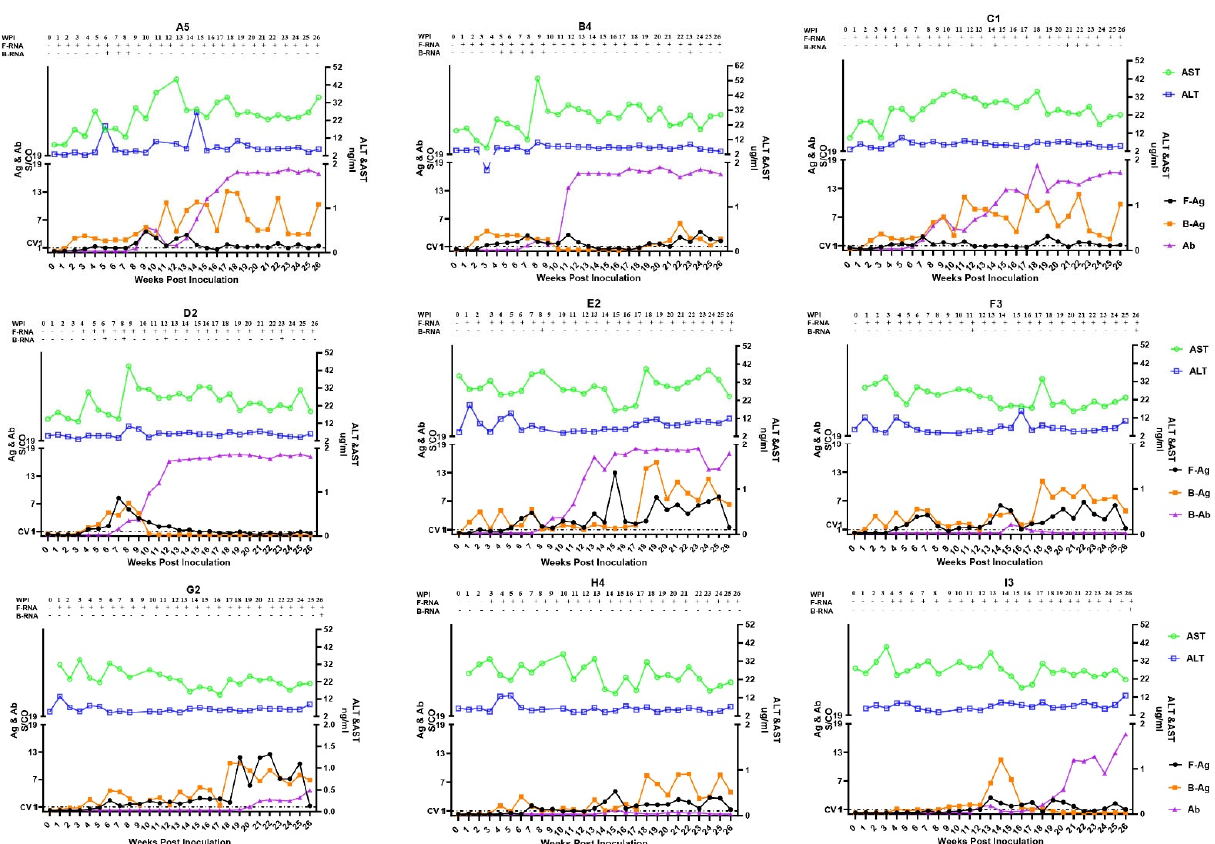
Figure 1. Dynamic of HEV markers and liver function tests in rabbits with chronic HEV infection. ( A5 , B4 , C1 , D2 , E2 , F3 , G2 , H4 , I3 ) are the number of each representative rabbit. Detection of HEV RNA, HEV antigen, liver function tests, and anti-HEV antibody detection in nine representative chronically infected rabbits, one rabbit per group. Serum and fecal samples were collected weekly for immediate analysis. “-” for negative and “+” for positive of HEV RNA detection by RT-qPCR. Ab, antibody; Ag, antigen; ALT, alanine aminotransferase; AST, aspartate aminotransferase; B, blood; F, feces; HEV, hepatitis E virus; WPI, weeks